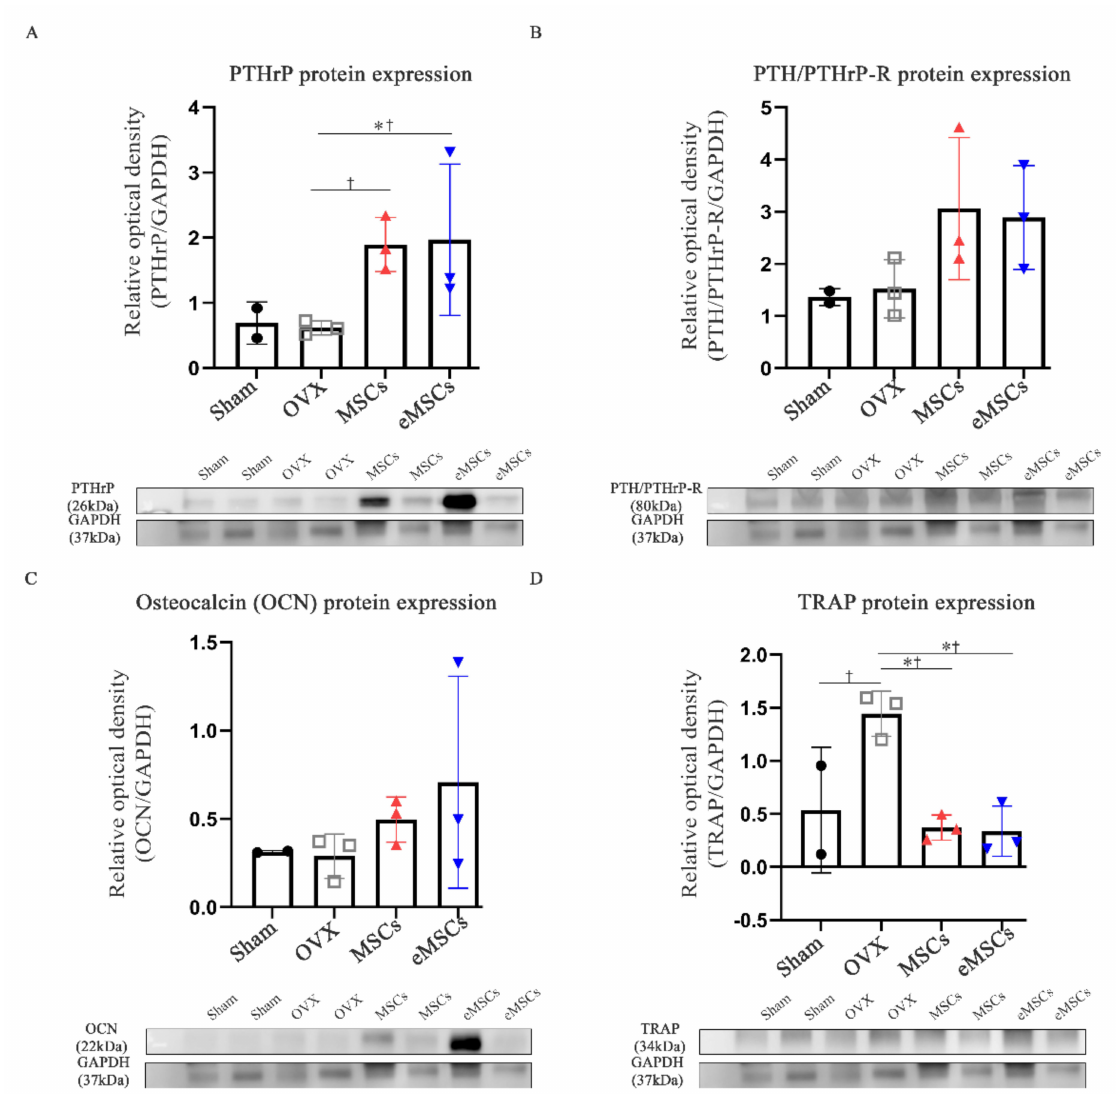
Figure 6. Protein expression of PTHrP, PTH/PTHrP-R, and bone formation and resorption markers in the femur after the injection of eMSCs into OVX mice (10 weeks post-OVX). ( A ) Protein expression of PTHrP. ( B ) Protein expression of PTH/PTHrP-R. ( C ) Protein expression of osteocalcin (OCN). ( D ) Protein expression of TRAP. The data are represented as the mean ± SEM. Statistical significance was assessed using the Kruskal–Wallis test with LSD (†) post hoc analysis and the Mann–Whitney (*) test: *† p < 0.05, n.s. = not